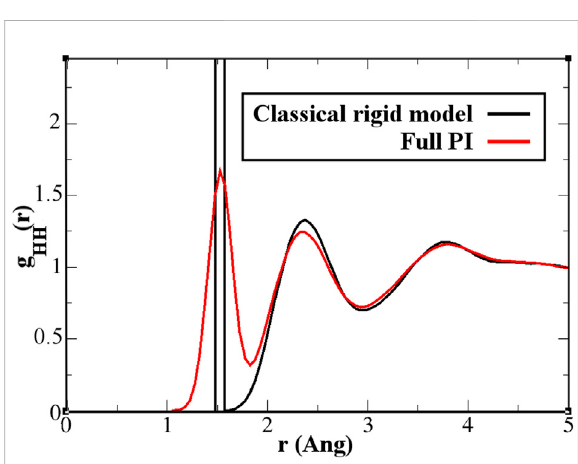
FIGURE 7 Hydrogen – hydrogen radial distribution function for a pure water system. The classical rigid model (black line) has a fi rst sharply localized peak, while thequantum model (redline)spreads theprobabilityover1 Å.Furthereffectsarevisible,althoughin a light form, also beyond the intramolecular and fi rst neighbor molecule